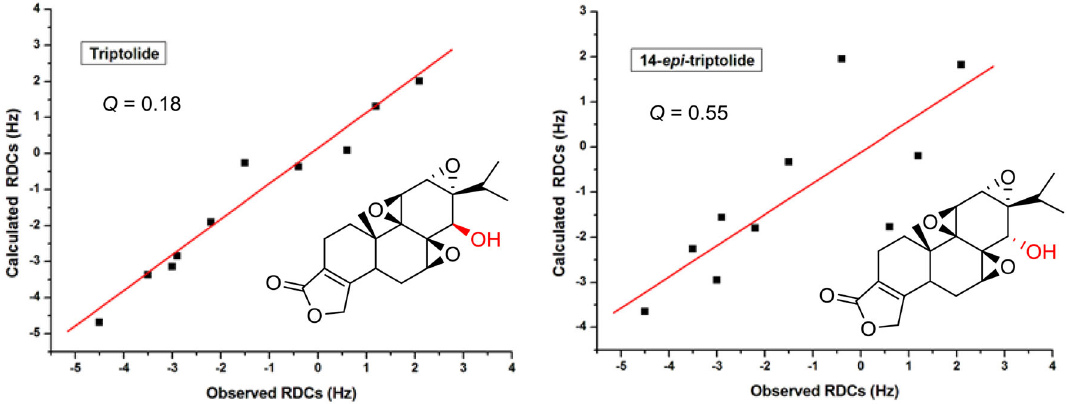
Fig. 6 Correlation between the experimental 1 D CH and the back-calculated RDC of triptolide in L , L -PIAF-OBn LCs using the X-ray structure of triptolide/14- epi -triptolide as the input. The RDC fitting was performed with SVD using MSpin software